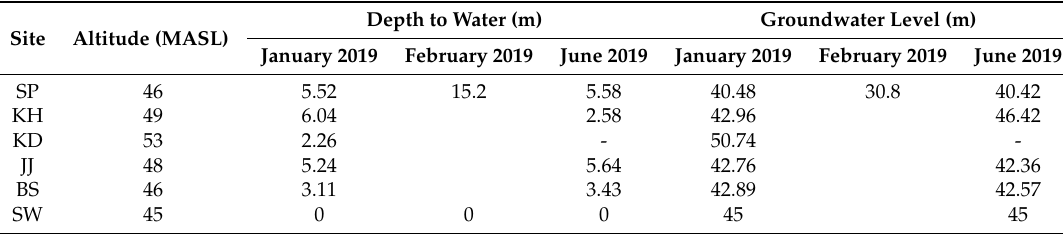
Table A1. The monitored altitude of study spots and groundwater level of wells in the study